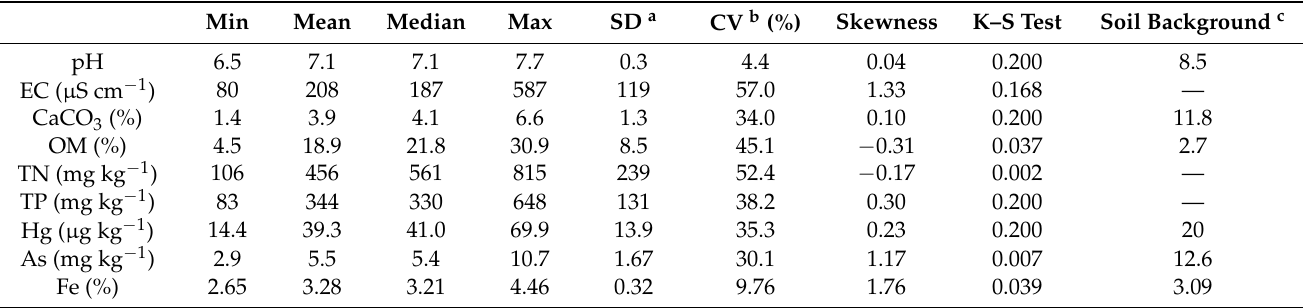
Table 1. Descriptive statistics of Hg and As concentrations and physicochemical properties in surface